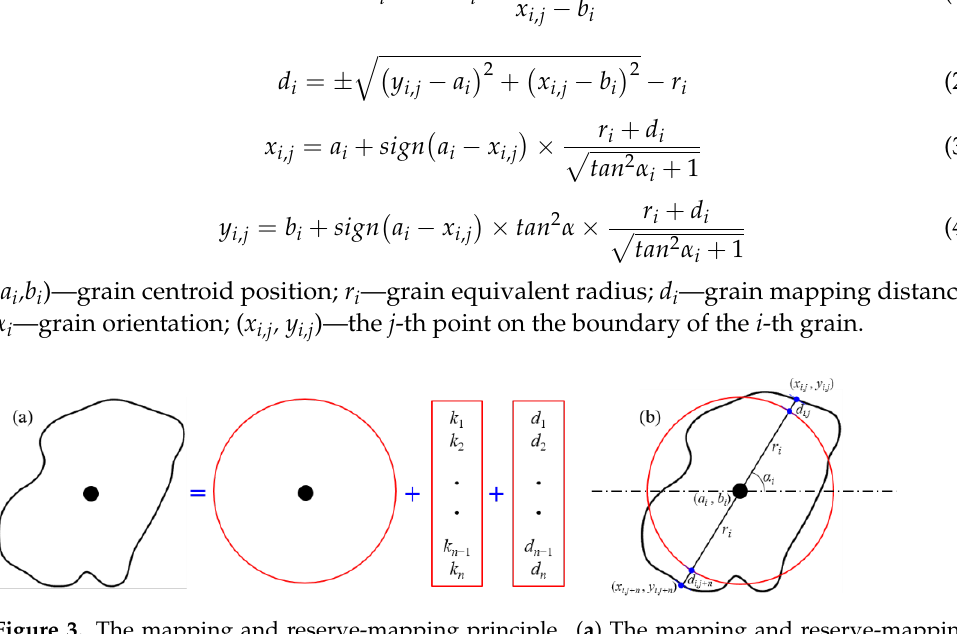
Figure 3. The mapping and reserve-mapping principle. ( a ) The mapping and reserve-mapping process between irregular boundary and circle boundary; ( b ) Parameters relationships between irregular boundary and circle boundary.